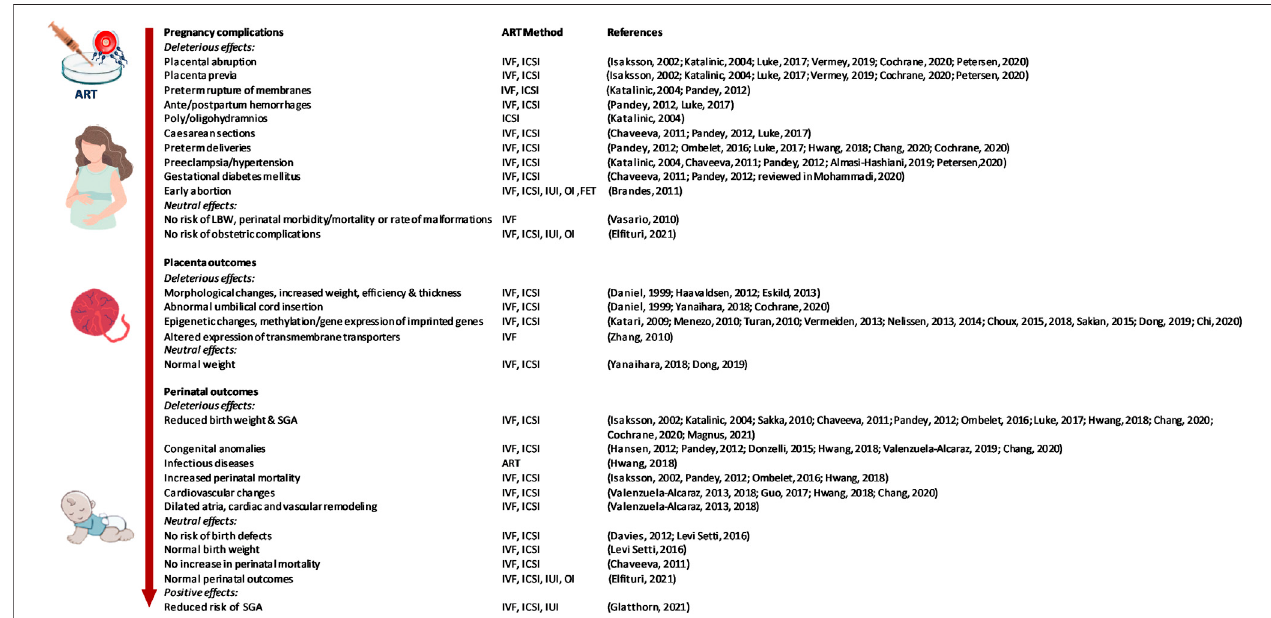
FIGURE 1 | The effect of the use of ART on pregnancy complications, placental and fetal adaptations, and perinatal health outcomes. Legend: SGA: Small for Gestational Age. FET: Frozen Embryo Transfer. IUI: Intra-Uterine Insemination, OI: Ovulation Induction with Clomiphene citrate.